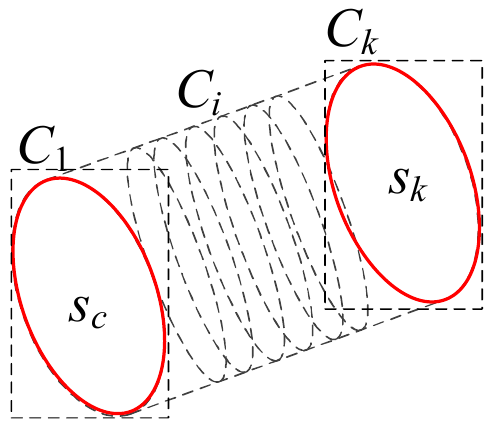
Figure 9. The distribution of the cross-sections of an MEP element. Because center points of representative sets represent the spatial position of an MEP element, this study utilizes the center point as the representative point. Without loss of generality, the MEP element with unchanged cross-section normal vectors utilizes representative points (the center points) of two outer cross-section curves to build the representative edge. The element with mutative cross-section normal vectors requires extracting representative points of each cross-section curve to obtain representative edge (edges). In fact, representative points of outer cross-section curves can be obtained by extracting boundary points of triangular